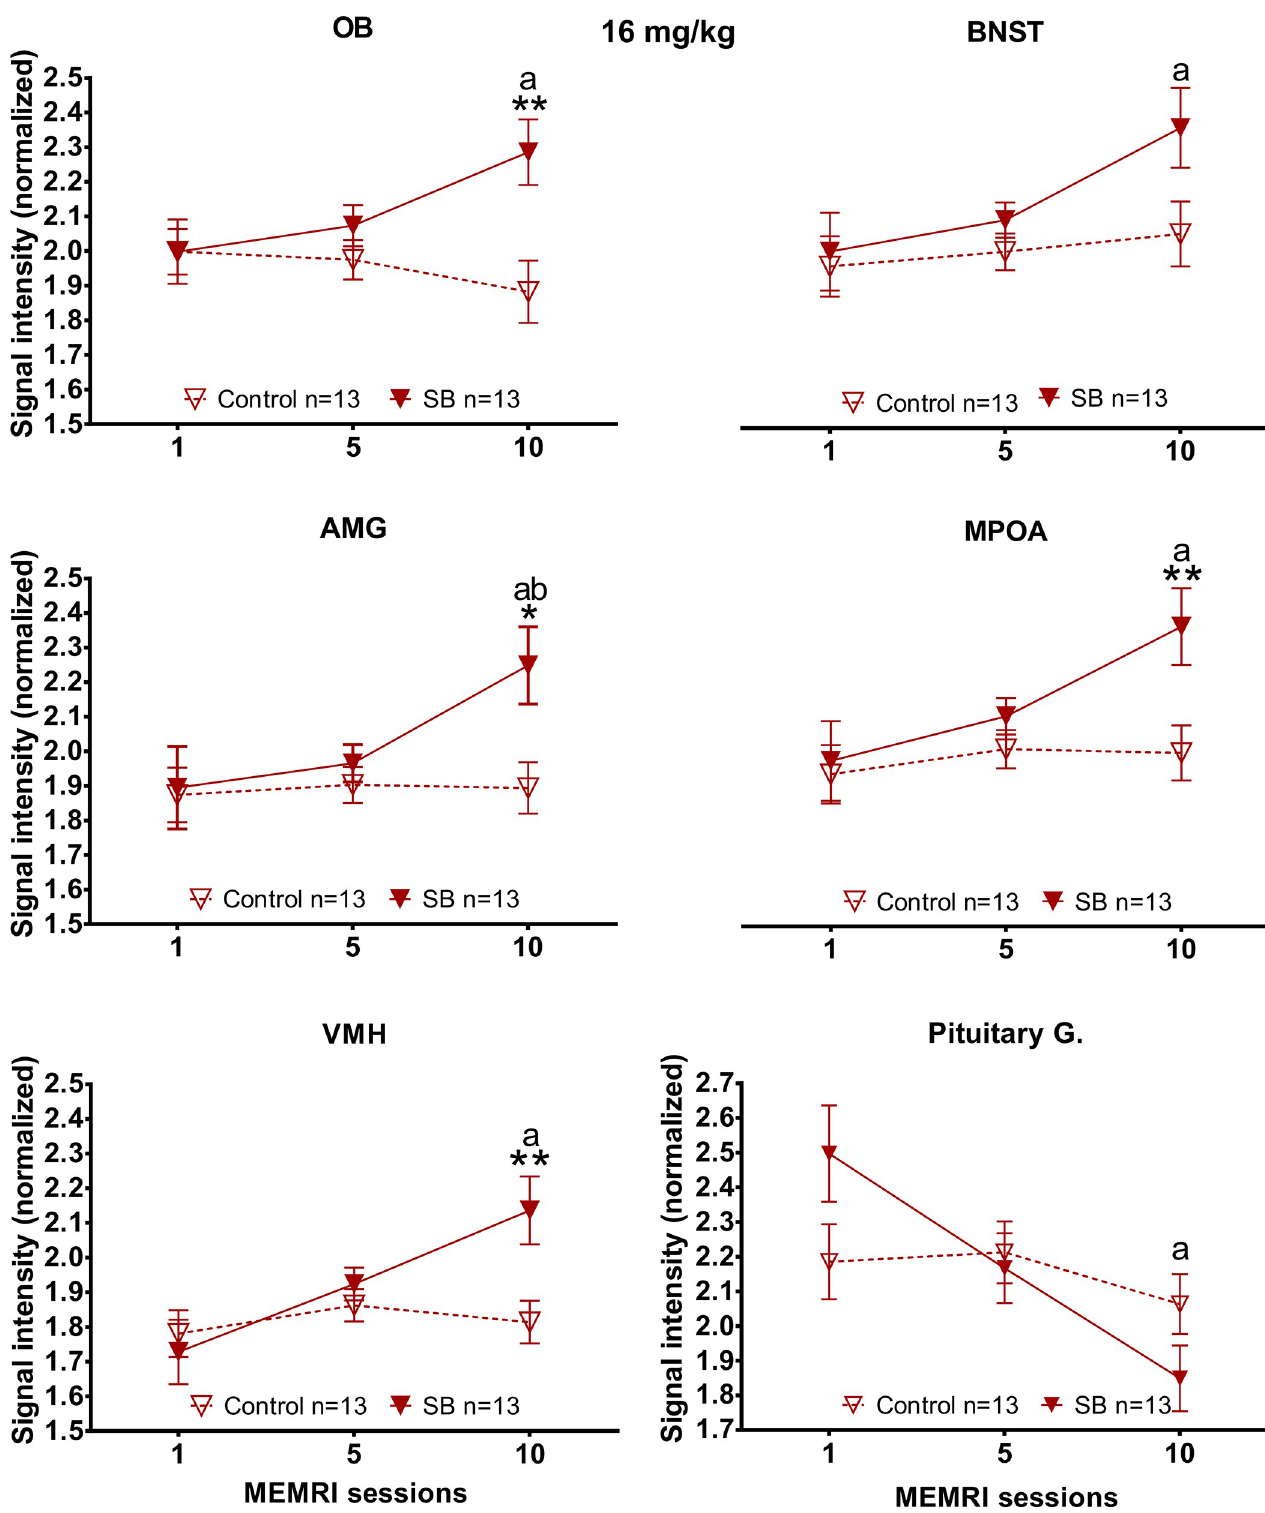
Fig 7. Signal intensity of the olfactory bulb (OB), the bed nucleus of the stria terminalis (BNST), the amygdala (AMG), the medial preoptic area (MPOA), the ventromedial hypothalamus (VMH) and the pituitary gland in subjects treated with 16 mg/kg of MnCl 2 . Data are expressed as mean ± SEM. � Different from control p < 0.05; �� p < 0.01. a Different from session 1 p < 0.05. b Different from session 5 p < 0.05.